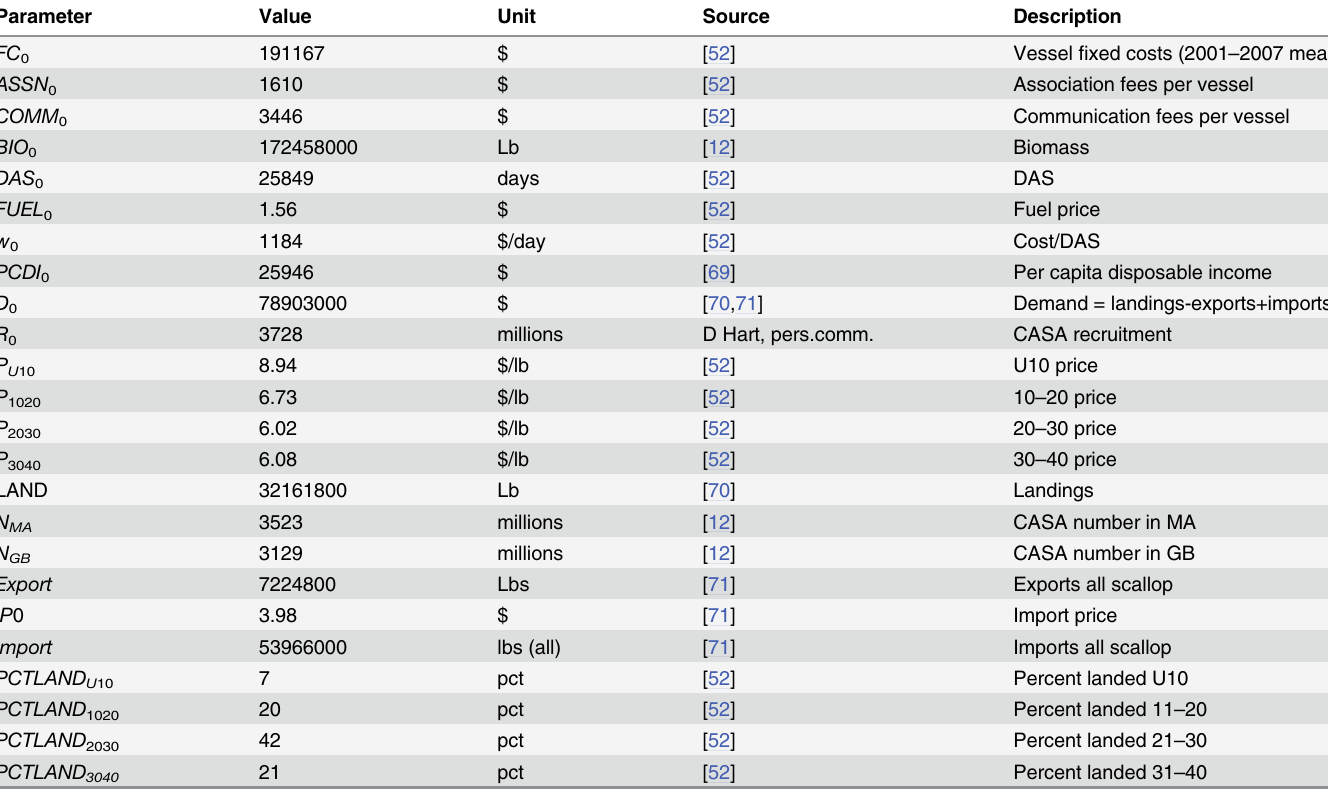
Table 5. Initial conditions for the socioeconomic and scallop submodels for year